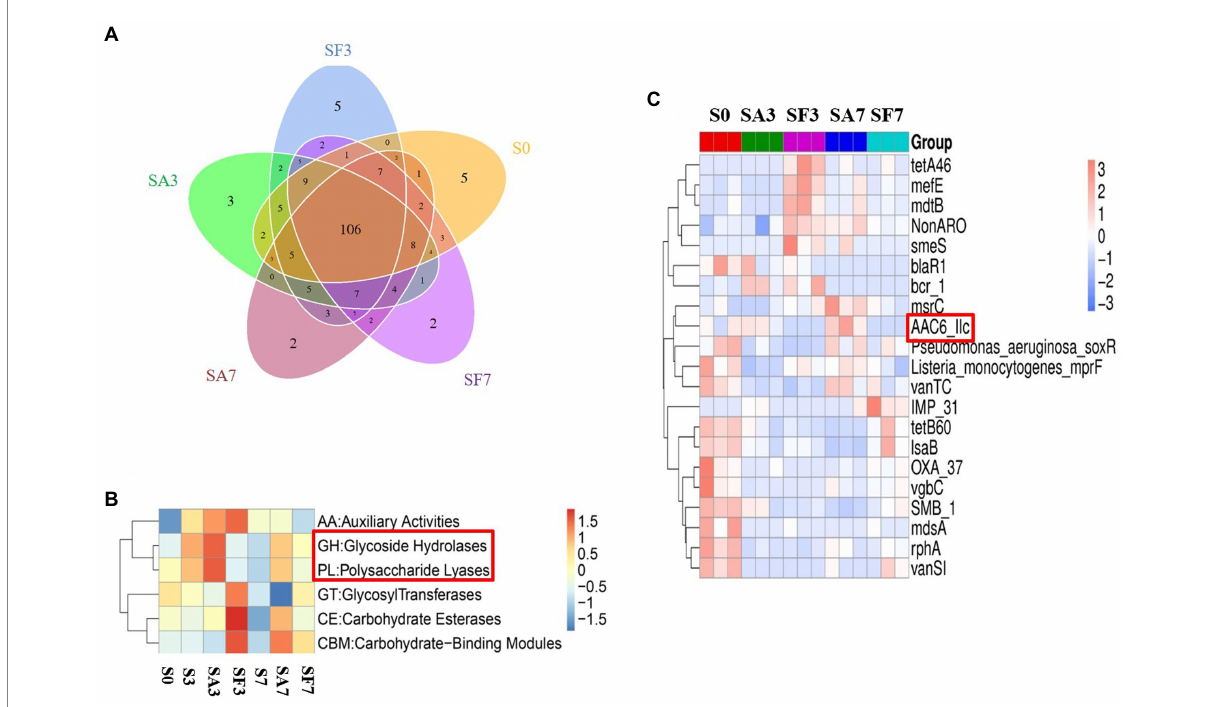
FIGURE 7 Differential abundance of functional resistance genes among different soil samples (A) Venn diagram showing the distribution of functional resistance genes among the five selected sample groups. (B) Heatmap of the differences in relative abundance of six CAZy classes among the samples. (C) Heatmap of the differences in relative abundance of the antibiotic resistance ontology (ARO) cluster among the samples. S0, Mock-inoculation control, before treatment; S3, mock-inoculation control, 3 dpi; S7, mock-inoculation control, 7 dpi; SA3, SA + FON treatment, 3 dpi; SA7, SA + FON treatment, 7 dpi; SF3, FON treatment, 3 dpi; SF7, FON treatment, 7 dpi. FON, Fusarium oxysporum f. sp. niveum ; SA, salicylic acid; dpi, days